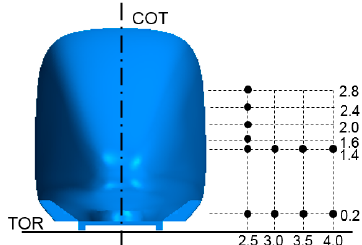
Figure 9. Position of the measurement point relative to center of track (COT) and top of rail (TOR).